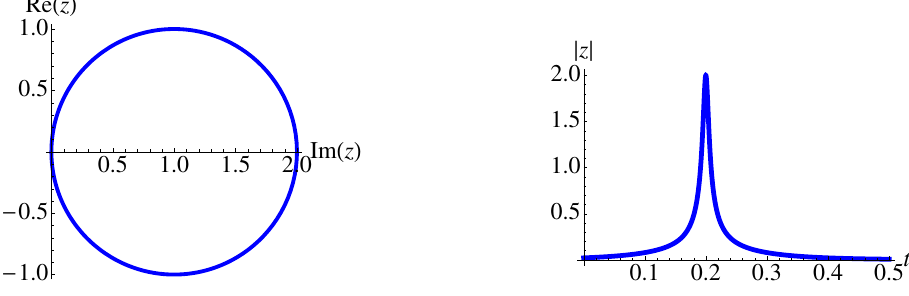
Figure 3 . The cross-ratio z = ( z 14 z 23 ) = ( z 21 z 34 ) as a function of t , where z i = exp(2 (cid:25)x i =(cid:12) ), x 1 = (cid:0) i(cid:15) , x 2 = ‘ 1 (cid:0) t and x 3 = ‘ 1 (cid:0) t (cid:0) i(cid:12)= 2, x 4 = i(cid:15) . Setting (cid:15) = 0 : 005, (cid:12) = 0 : 5 and ‘ 1 = 0 : 2, we see that the cross-ratio goes around z = 1 clockwise as the excitation on the left boundary enters the interval at t = ‘ 1